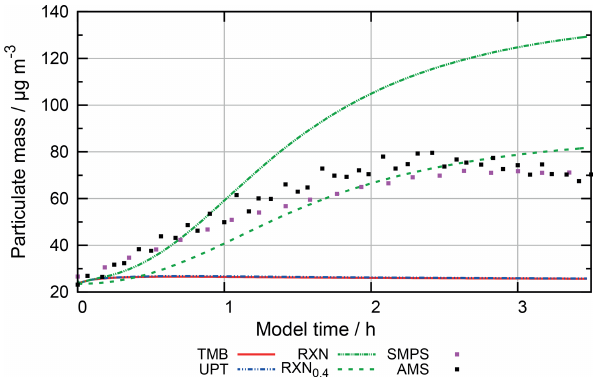
Figure 19. Comparison of dry particle mass in the various sensitiv- ity studies with SMPS and AMS